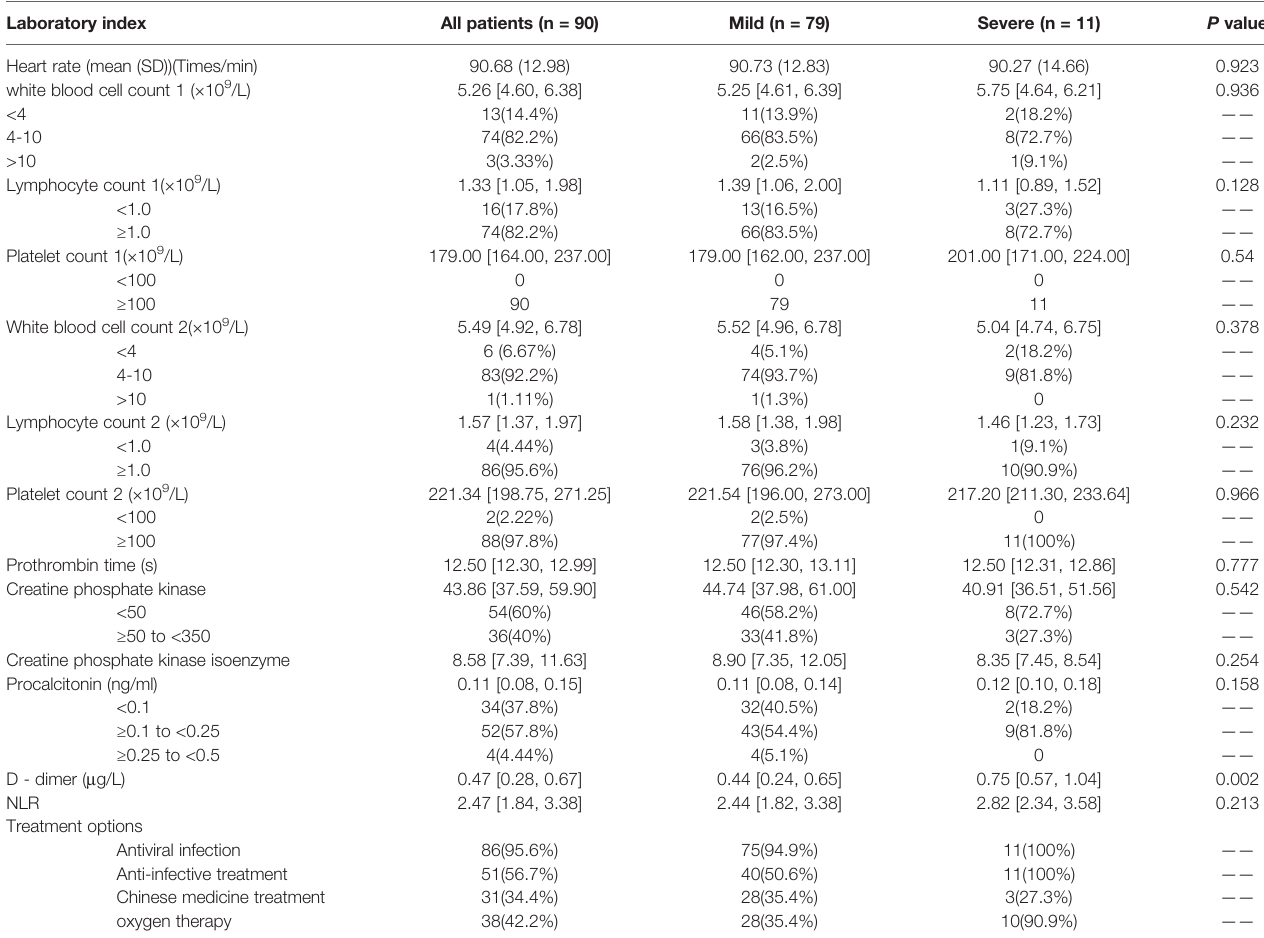
TABLE 2 | Laboratory test results and treatment regimens for COVID-19 patients during hospitalization. Laboratory index